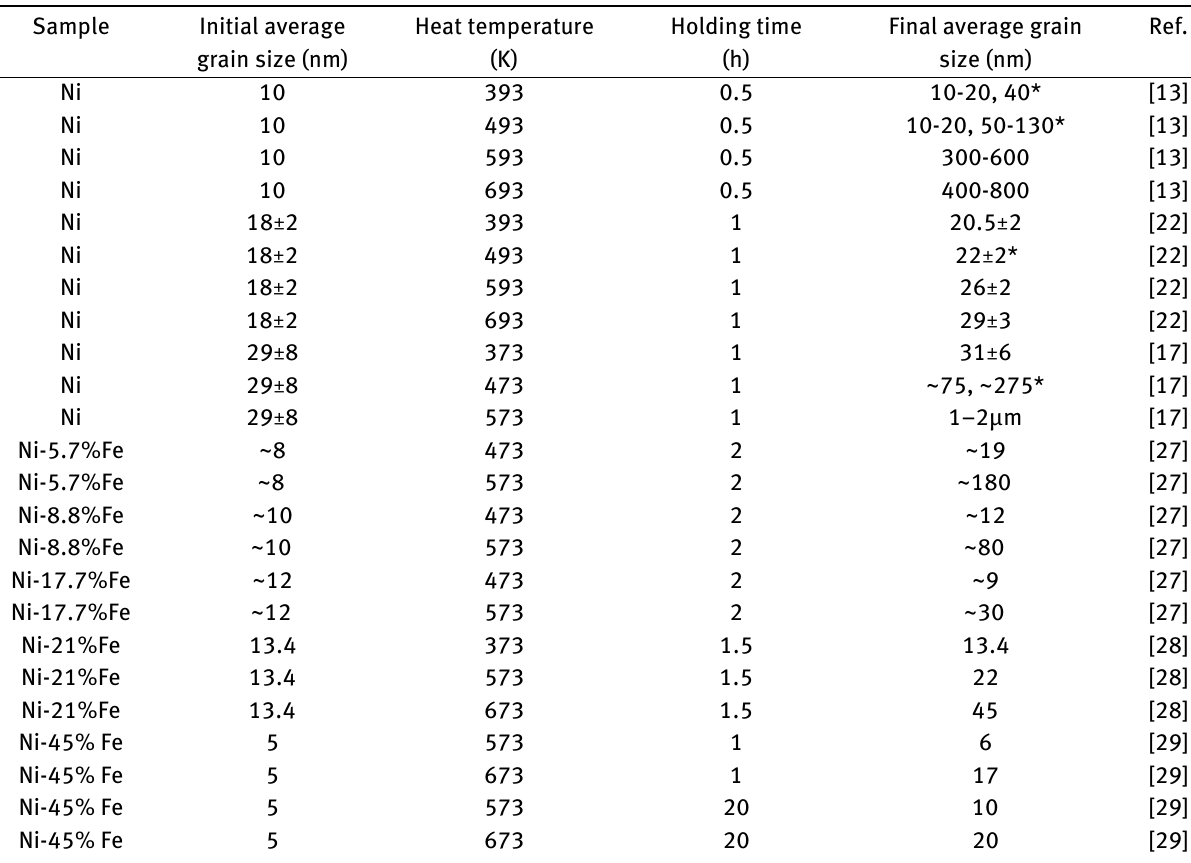
Table 1: A short summary of the grain size change for bulk electrodeposited NC Ni and Ni-Fe alloys after isothermal annealing process at different temperatures and